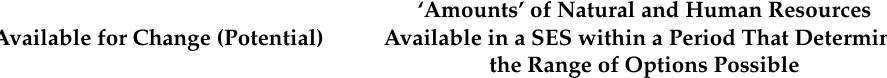
Table 1. Indicative definitions of Lower Level Properties (LLPs). Based on